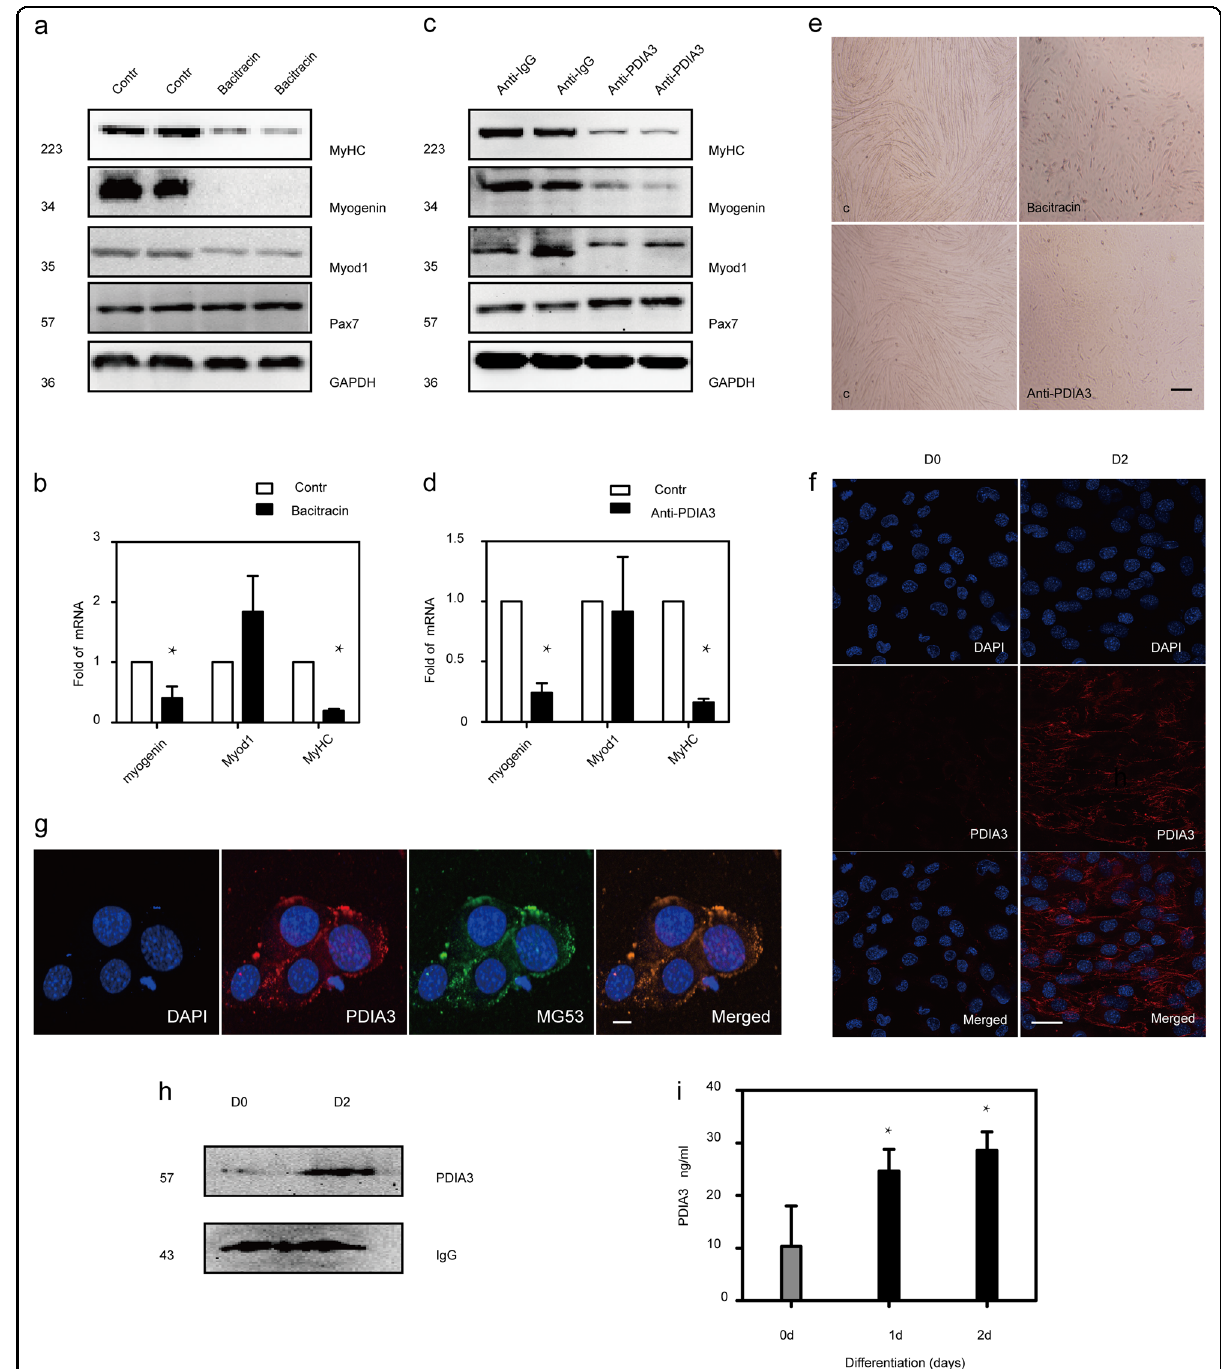
Fig. 6 The role of extracellular PDIA3 in myoblast differentiation and fusion. a , b C2C12 myoblasts were induced to differentiate for 48 h and treated with bacitracin. After 24 h, the myogenin, Myod1, and MyHC levels were measured by immunoblotting and PCR (* P < 0.05 vs. Control; n = 4). c , d C2C12 myoblasts were induced to differentiate for 48 h and treated with a monoclonal anti-PDIA3 antibody or anti-IgG (10 µg/ml). After 24 h, the myogenin, Myod1, and MyHC levels were measured by immunoblotting and PCR (* P < 0.05 vs. Control; n = 4). e C2C12 myoblasts were induced to differentiate for 48 h and treated with bacitracin and a monoclonal anti-PDIA3 antibody. Myotube formation was observed by a microscope. Scale 200 µm. f C2C12 myoblasts were differentiated for 48 h and then subjected to the live imaging of PDIA3. Scale 40 µm. g C2C12 myoblasts were differentiated for 48 h and then subjected to the live imaging of PDIA3 and MG53. Scale 40 µm. h C2C12 myoblasts were induced to differentiate for 48 h. The level of PDIA3 on the cell membrane was measured by immunoblotting. i C2C12 myoblasts were induced to differentiate for 24 and 48 h. The level of PDIA3 in the cellular supernatant was measured by using an anti-PDIA3 ELISA kit (* P < 0.05 vs. Control; n = 4).